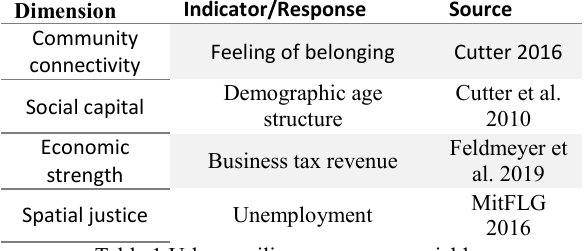
Table 1.Urban resilience response variables